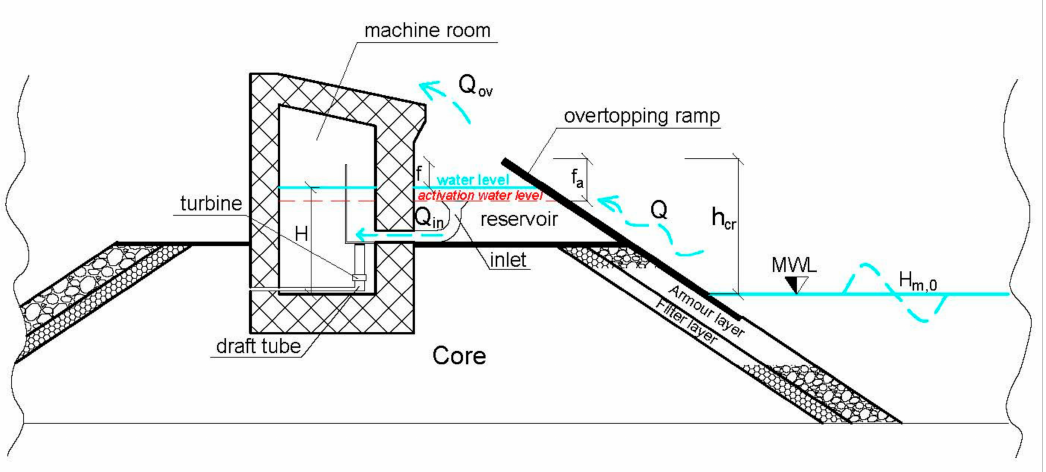
Figure 4. OBREC geometry layout and main